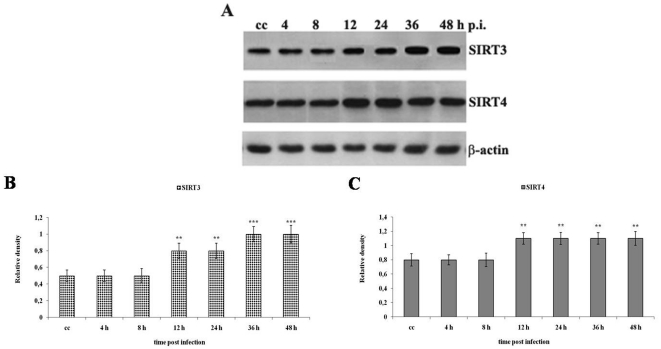
CCoV-II infection modulates the gene regulation of SIRT3 and SIRT4. (A) To perform Northern blot assay, RNA was extracted from mock-infected (lanes cc, control cells) and infected cells at the indicated times, electrophoresed and hybridized with a labelled probe as described under Material and Methods. β-actin was used as loading control. Blot is representative of three separate experiments. (B) Densitometric analysis of blots relative to SIRT3. The bars represent the mean ± SEM of the results from three separate experiments. Significant differences between CCoV-II-infected cells and control cells are indicated by probability P. **P <0.01, and ***P <0.001. (C) Densitometric analysis of blots relative to SIRT4. The bars represent the mean ± SEM of the results from three separate experiments. Significant differences between CCoV-II-infected cells and control cells are indicated by probability P. **P <0.01.